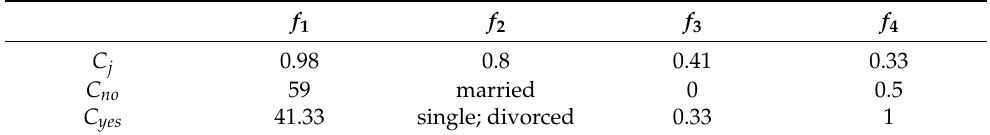
Table 5. Reduced